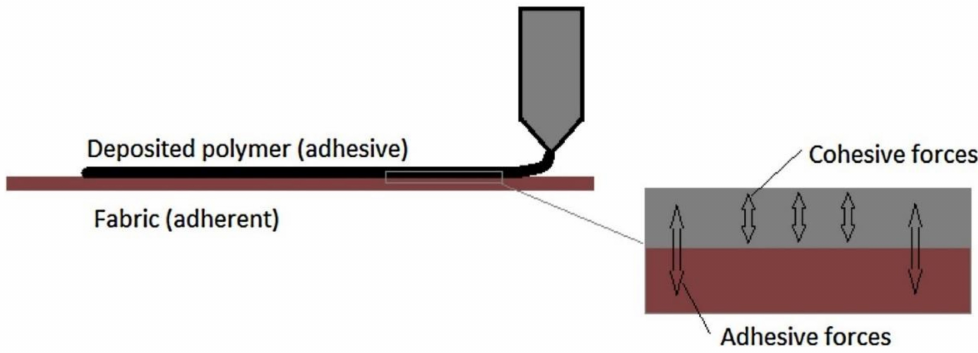
Figure 23. Adhesive and cohesive forces, with deposition of polymer as an adhesive to fabric as an adherent (Reproduced with permission from Reference [176], copyright 2017, Elsevier).